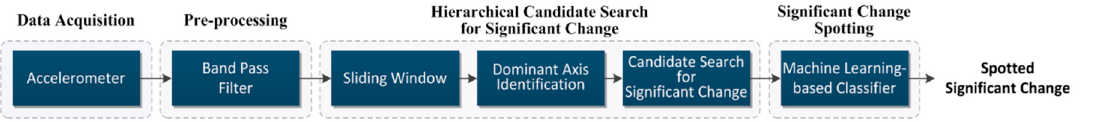
Figure 2. Framework of the hierarchical candidate search for significant change from raw data.